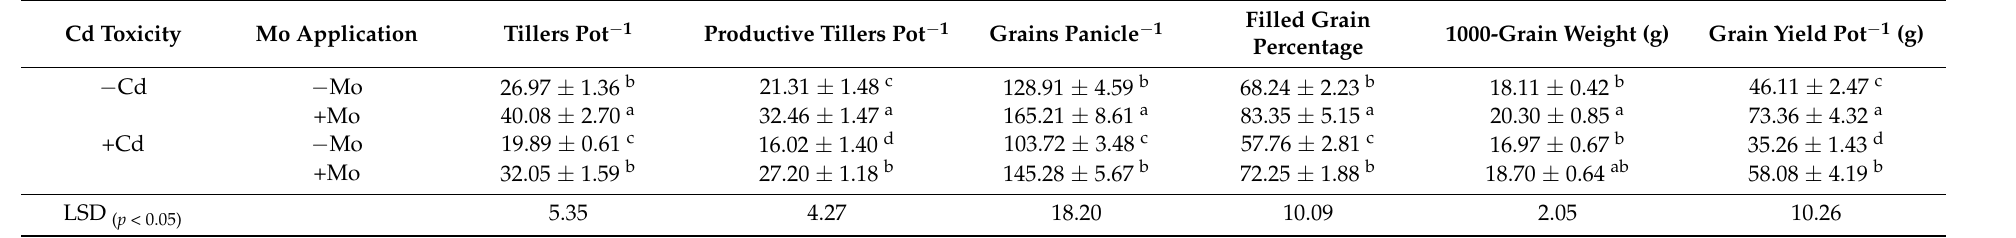
Table 1. Influence of Mo supply and Cd toxicity on aromatic rice yield and associated attributes.